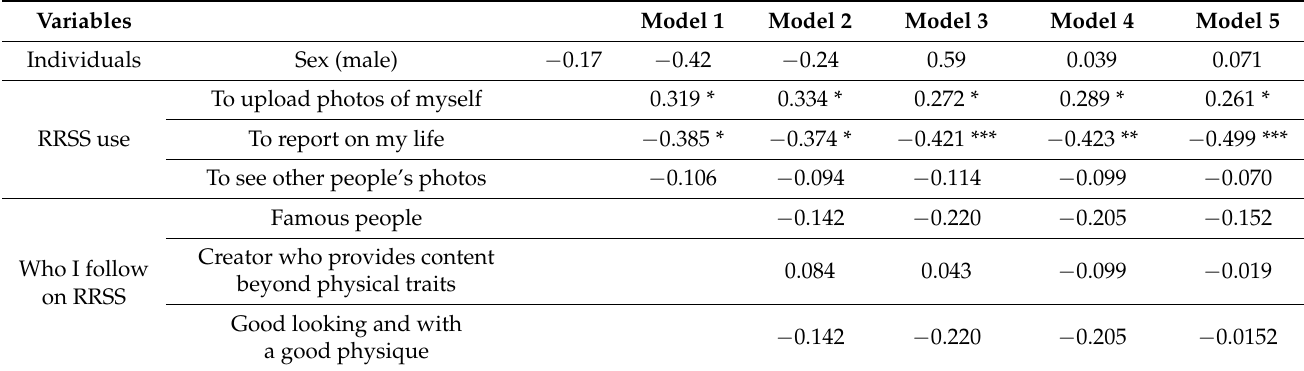
Table 4. Explanatory models of the degree of risk of developing